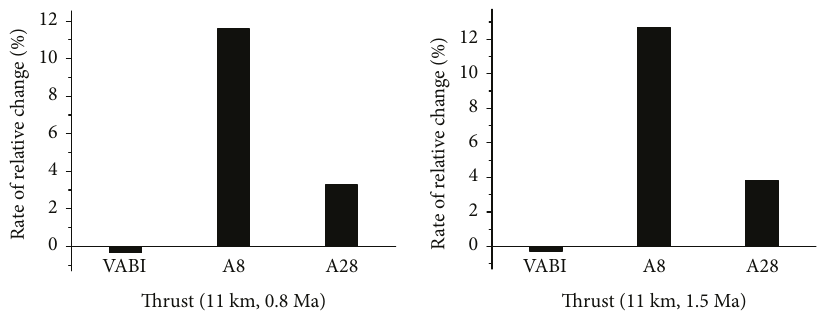
Figure 9: Sensitivity analysis of variable geometries on thrust (part 2).